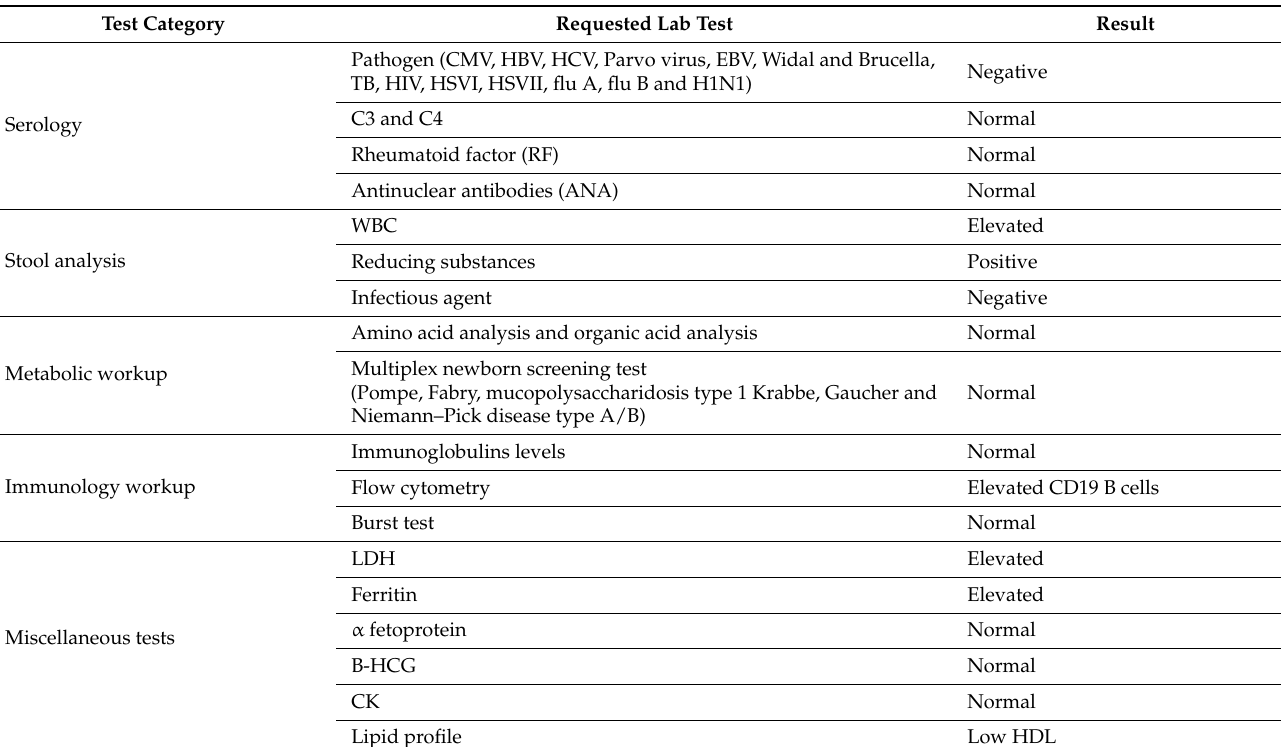
Figure 2. Overview of the patient’s presentation. ( A ) The participating family’s pedigree. ( B ) Chro- matograms of the variant in NOD2 (c.1190C>T). ( C ) The conservation of the amino acid change (p.Pro397Leu) across species from UCSC genome browser. Red rectangles surround the variant. Table 1. Results of lab tests conducted during the patient’s hospital